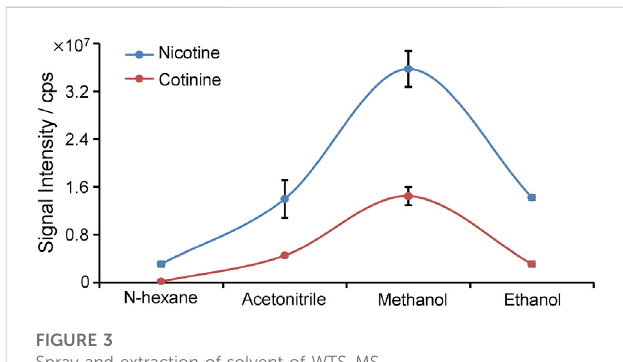
FIGURE 3 Spray and extraction of solvent of